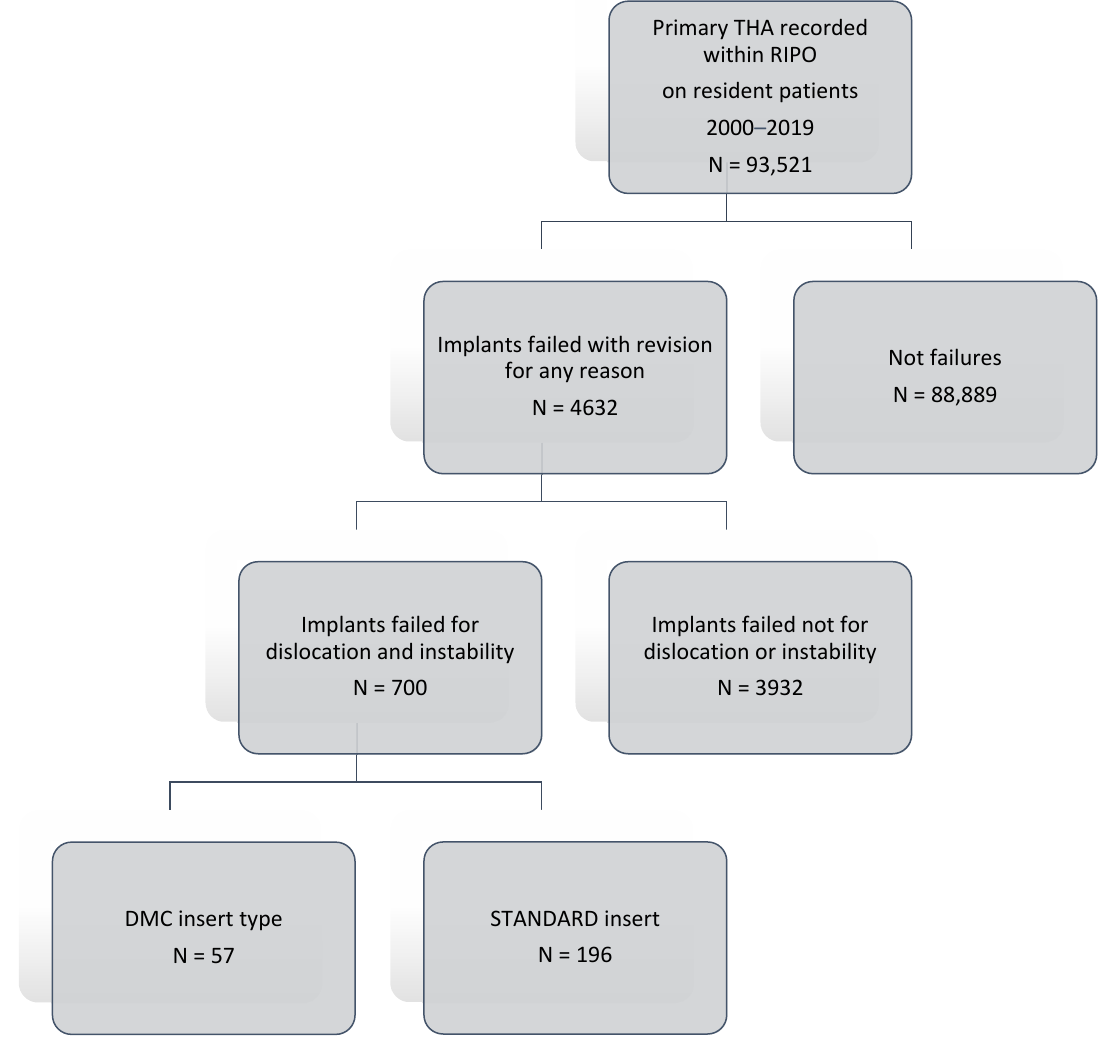
Figure 1. Patient selection flow-chart.